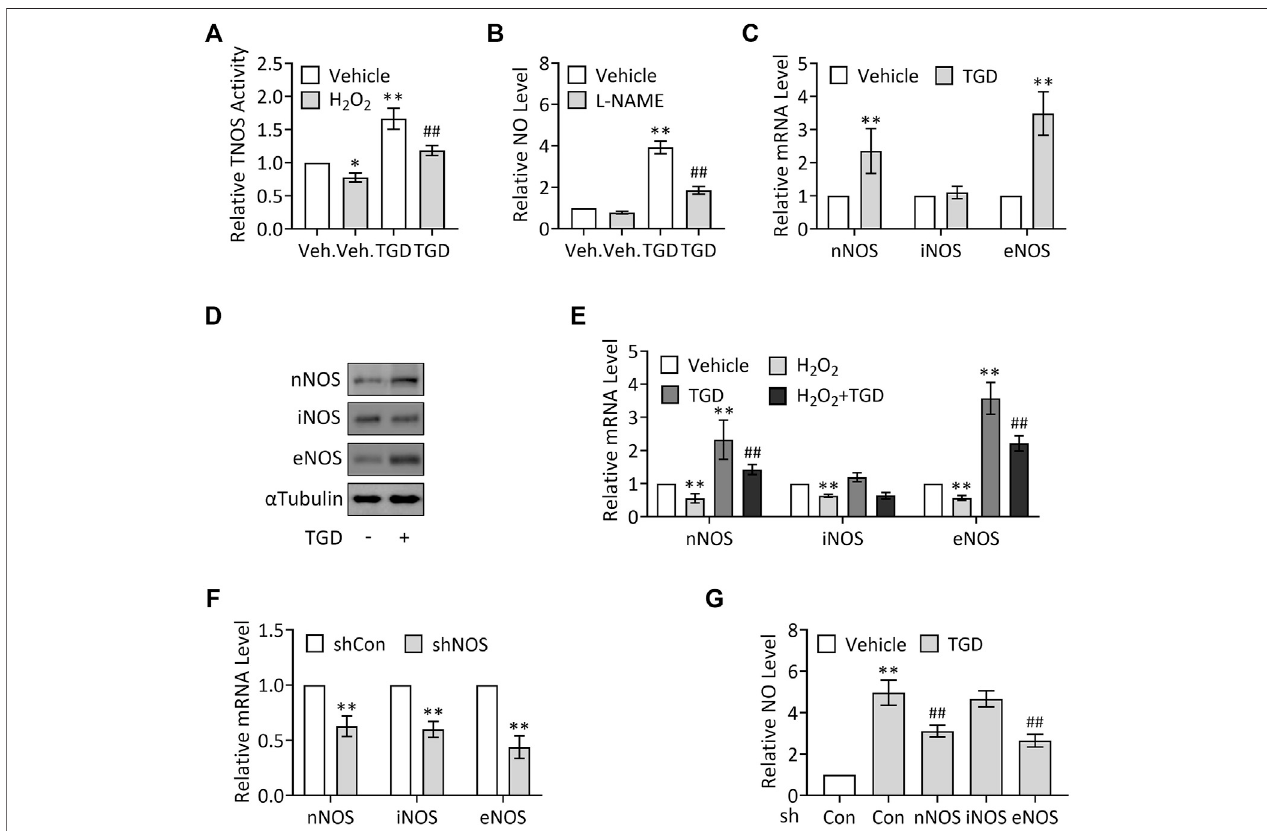
FIGURE 3 | TGD enhances NOS activity and induces the expression of nNOS and eNOS. (A) Relative TNOS activity in TEV-1 cells in the presence or absence of 500 μ M H 2 O 2 for3 h and then treatedwith orwithoutTGD at 25 mg/ml for 24 h. (B) Relative NOlevels inTEV-1 cells inthe presence orabsenceof100 μ M L-NAMEfor 12 handthentreatedwithorwithoutTGDat25 mg/mlfor24 h (C) RelativemRNAlevelsofnNOS,iNOSandeNOSinTEV-1cellstreatedwithorwithoutTGDat25 mg/ mlfor24 h (D) WesternblotanalysisfornNOS, iNOSand eNOSinTEV-1 cellstreatedwithorwithoutTGDat25 mg/ml for24 h (E) RelativemRNAlevels ofnNOS, iNOSandeNOSinTEV-1cellsinthepresenceorabsenceof500 μ MH 2 O 2 for3 handthentreatedwithorwithoutTGDat25 mg/ml for24 h (F) RelativemRNAlevelsof nNOS,iNOSandeNOSinTEV-1cellstransfectedwithcontrolshRNA,nNOS-shRNA,iNOS-shRNAoreNOS-shRNAandculturedfor72 h (G) RelativeNOlevelsinTEV- 1 cells transfected with nNOS-shRNA, iNOS-shRNA or eNOS-shRNA and cultured for 48 h, followed by treatment with or without TGD at 25 mg/ml for 24 h.